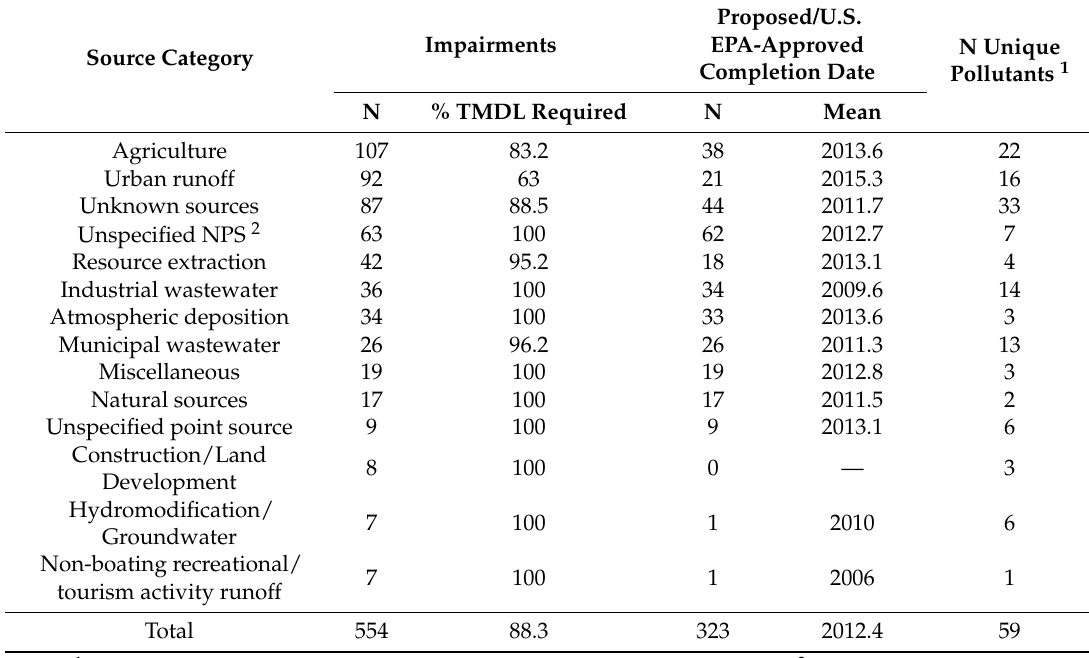
Table 2. Surface water impairments by source category and frequency in the Bay-Delta,